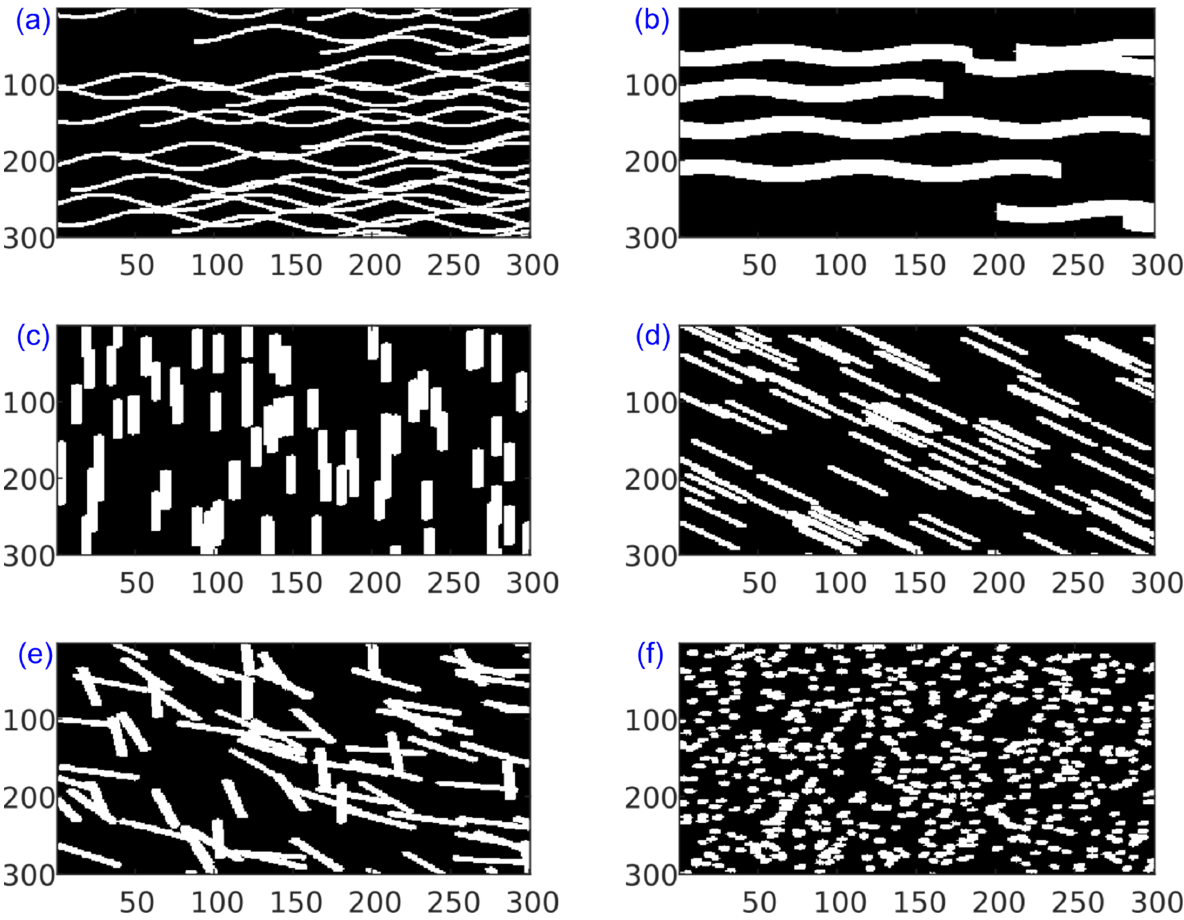
Figure 5. Training images generated using the code TiGenerator [28], with different spatial orders, orientations, and degrees of connectivity of the different (white) features embedded into a (black) matrix. The parameters used to create the subfigures ( a – f ) are indicated in Table